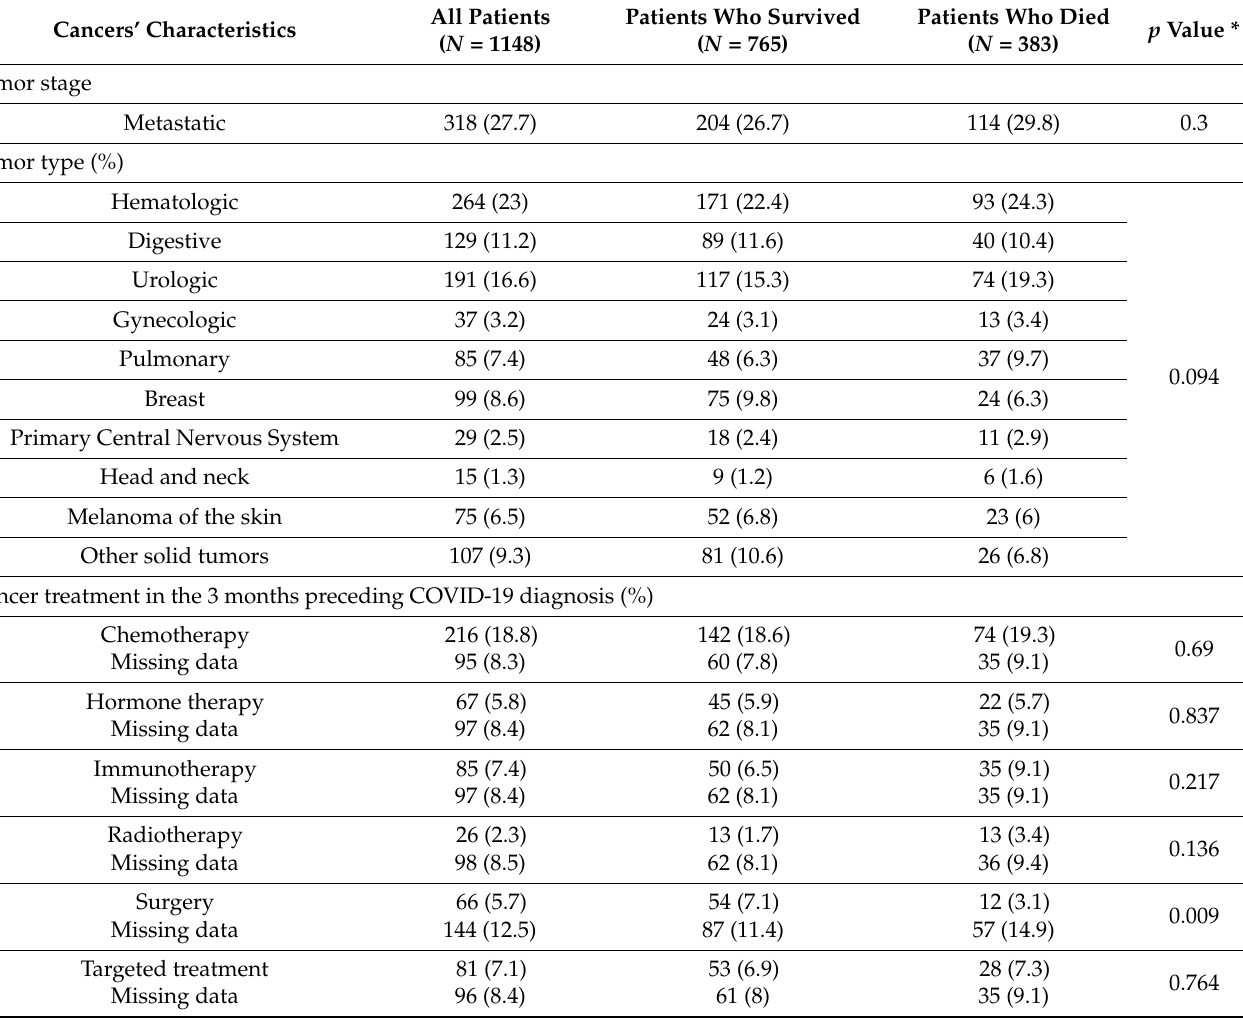
Table 2. Tumor characteristics among patients with cancer and confirmed COVID-19. * Groups were compared excluding missing data and using Pearson chi-square or Student T test as appropriate. All Cancers’ Characteristics